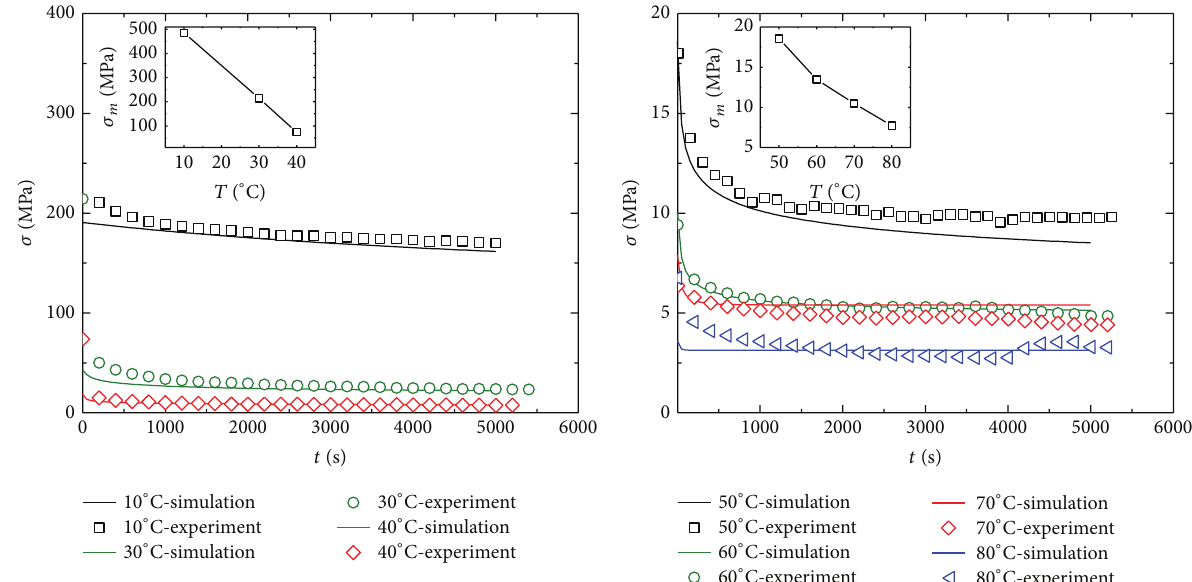
Figure 8: Temporal development of loading and stress relaxation experiments and their associated simulations under different isothermal